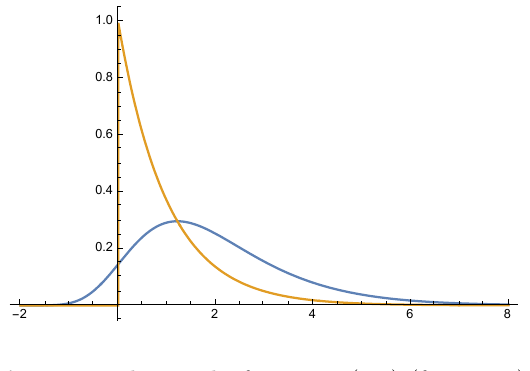
Figure 2 . The weight functions (5.6) (for (cid:13) = 1).